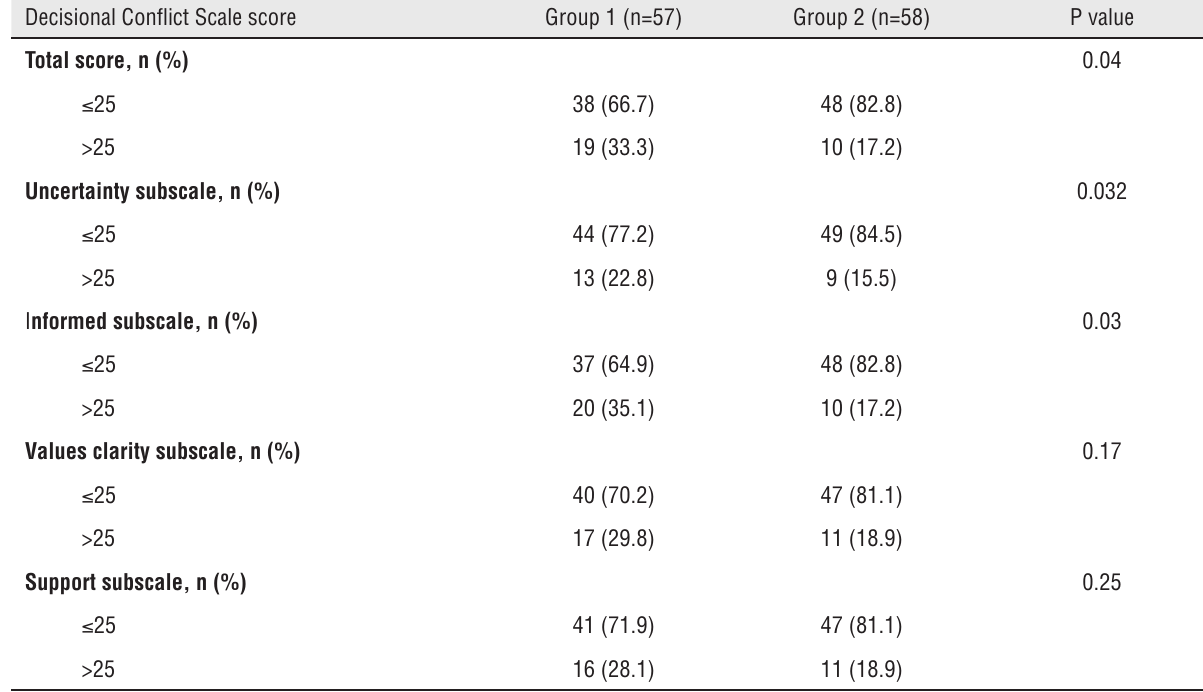
Table 2 - Comparison of the two groups for Decisional Conflict Scale scores. Decisional Conflict Scale score